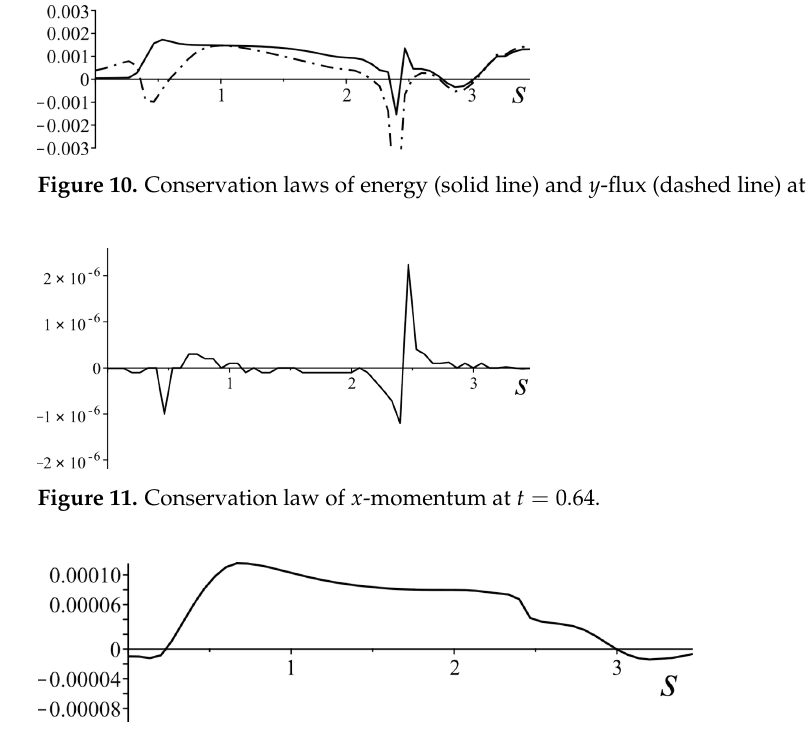
Figure 12. Conservation law of center-of-mass along axis x at t =